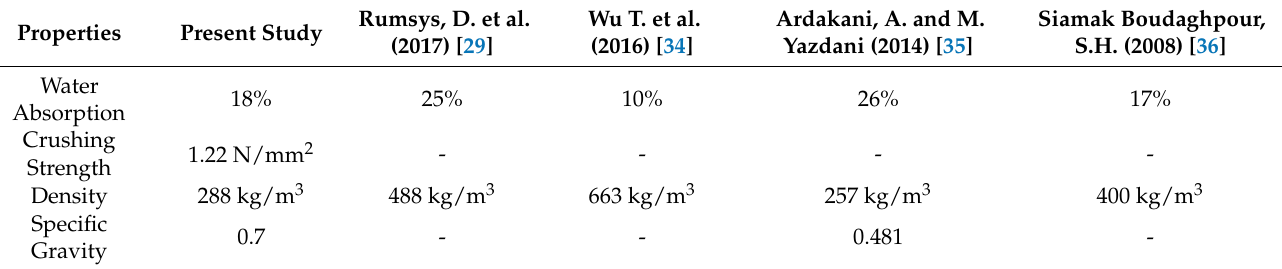
Table 4. Properties of expanded Clay Aggregate.